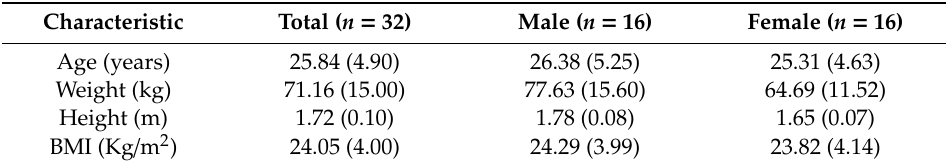
Table 1. Participants’ characteristics.